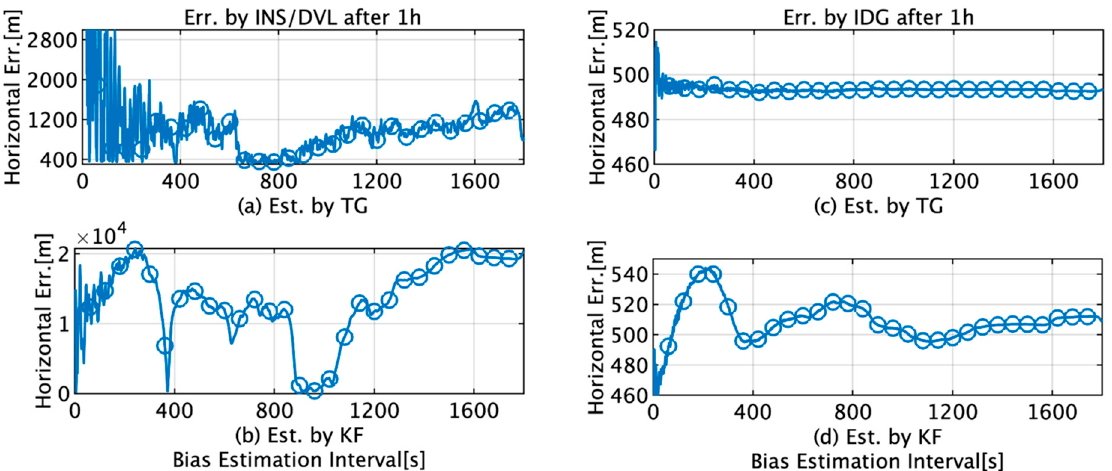
Figure 13. Horizontal position errors after 1 h estimated by INS/DVL and IDG with initial bias estimation by TG and KF; ( a ) horizontal error by INS/DVL with initial bias estimation by TG; ( b ) horizontal error by INS/DVL with initial bias estimation by KF; ( c ) horizontal error by IDG with initial bias estimation by TG; ( d ) horizontal error by IDG with initial bias estimation by KF.